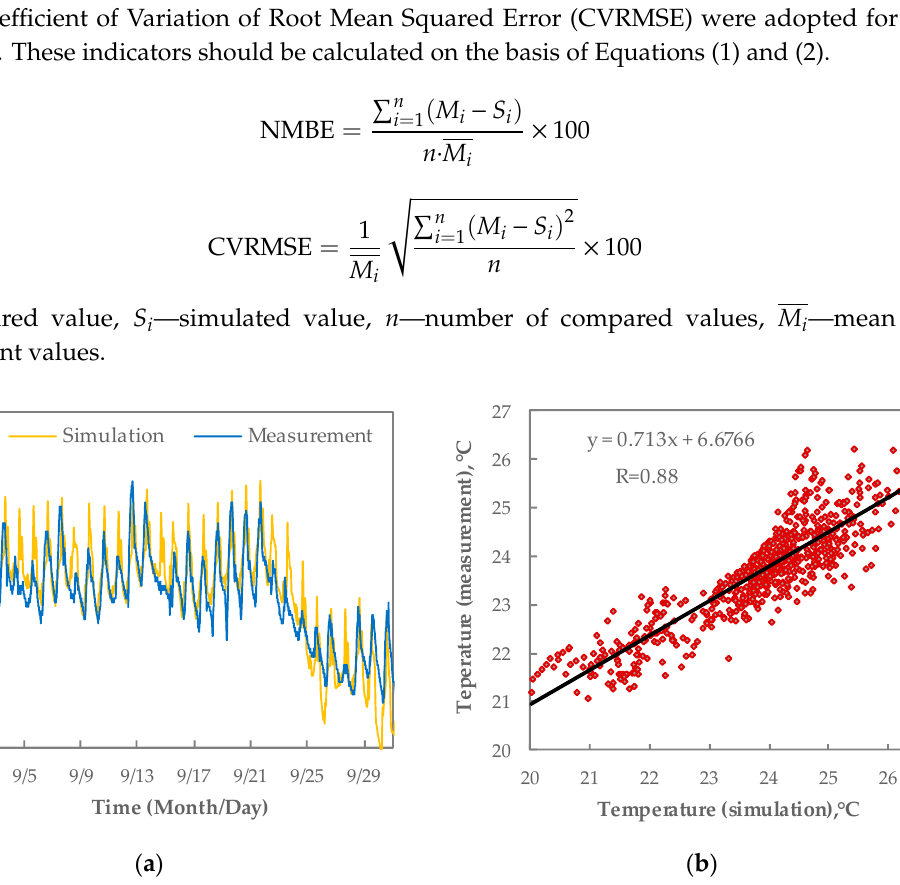
Figure 5. Variation of instantaneous value ( a ) and correlation ( b ) of measured and calculated indoor temperature for the living room zone.